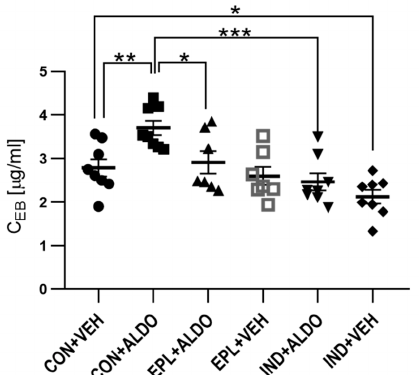
6 of 16 Figure 2. Dose-dependent effect of ALDO on vascular permeability. n = 6–8; n for each group is the number of skin samples, not the number of animals; 10 rats were used in this experiment; data are